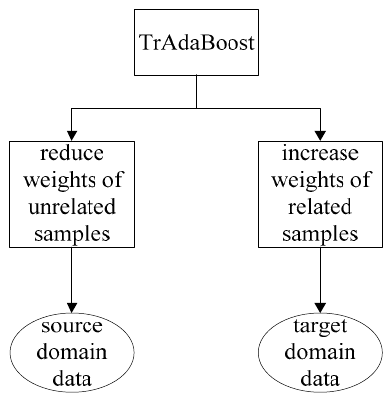
Figure 1. Training principle of the TrAdaBoost method.